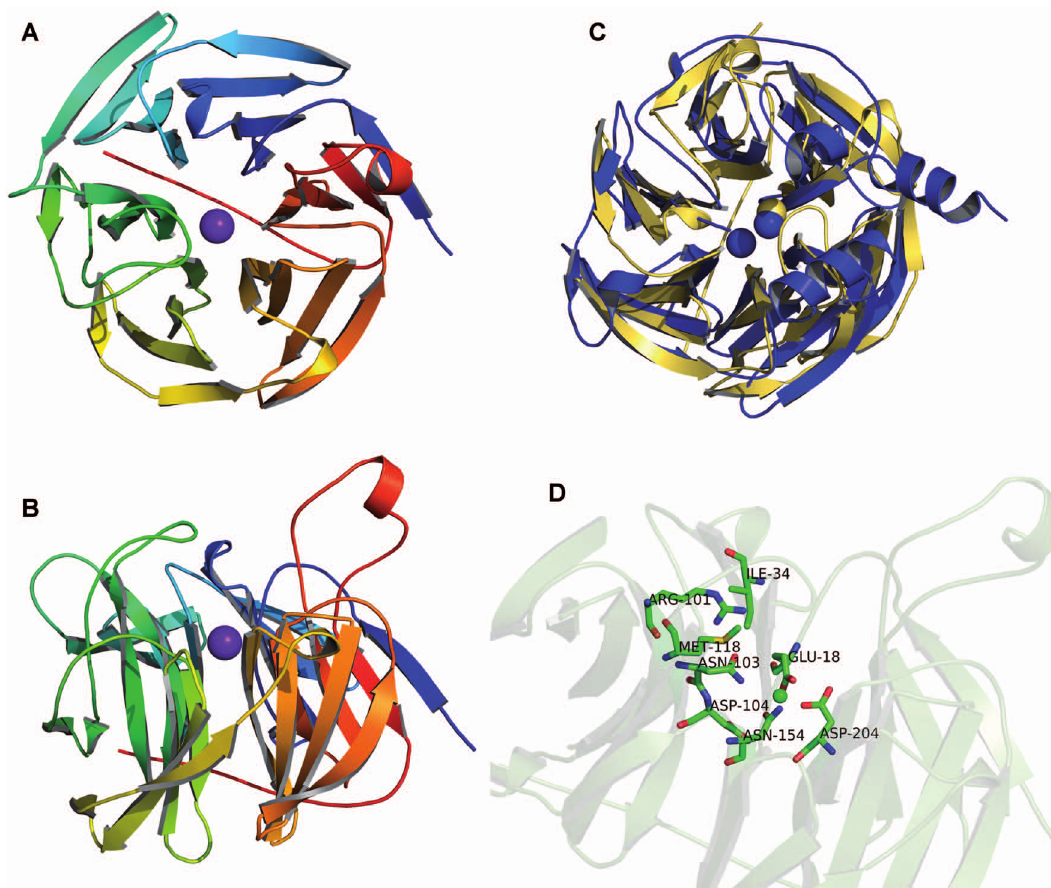
Figure 4 Ca 2 q -bound crystal structure of human